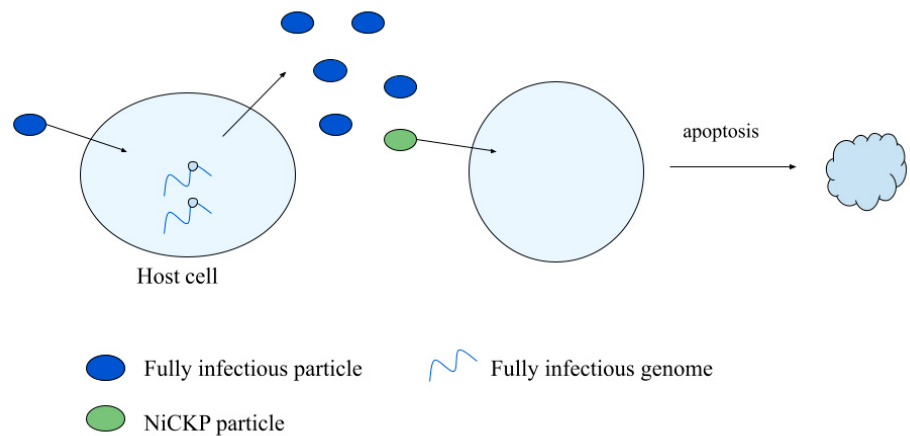
Figure 6. A non-infectious cell killing particle can trigger apoptosis in a cell .